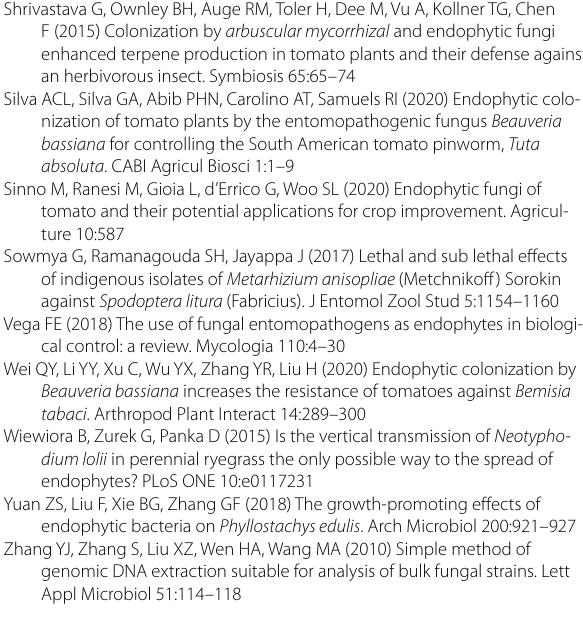
lished maps and institutional